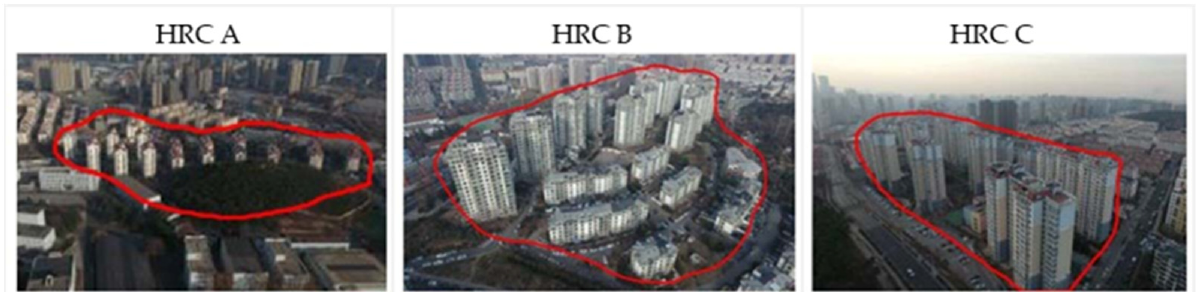
Figure 3. Three selected